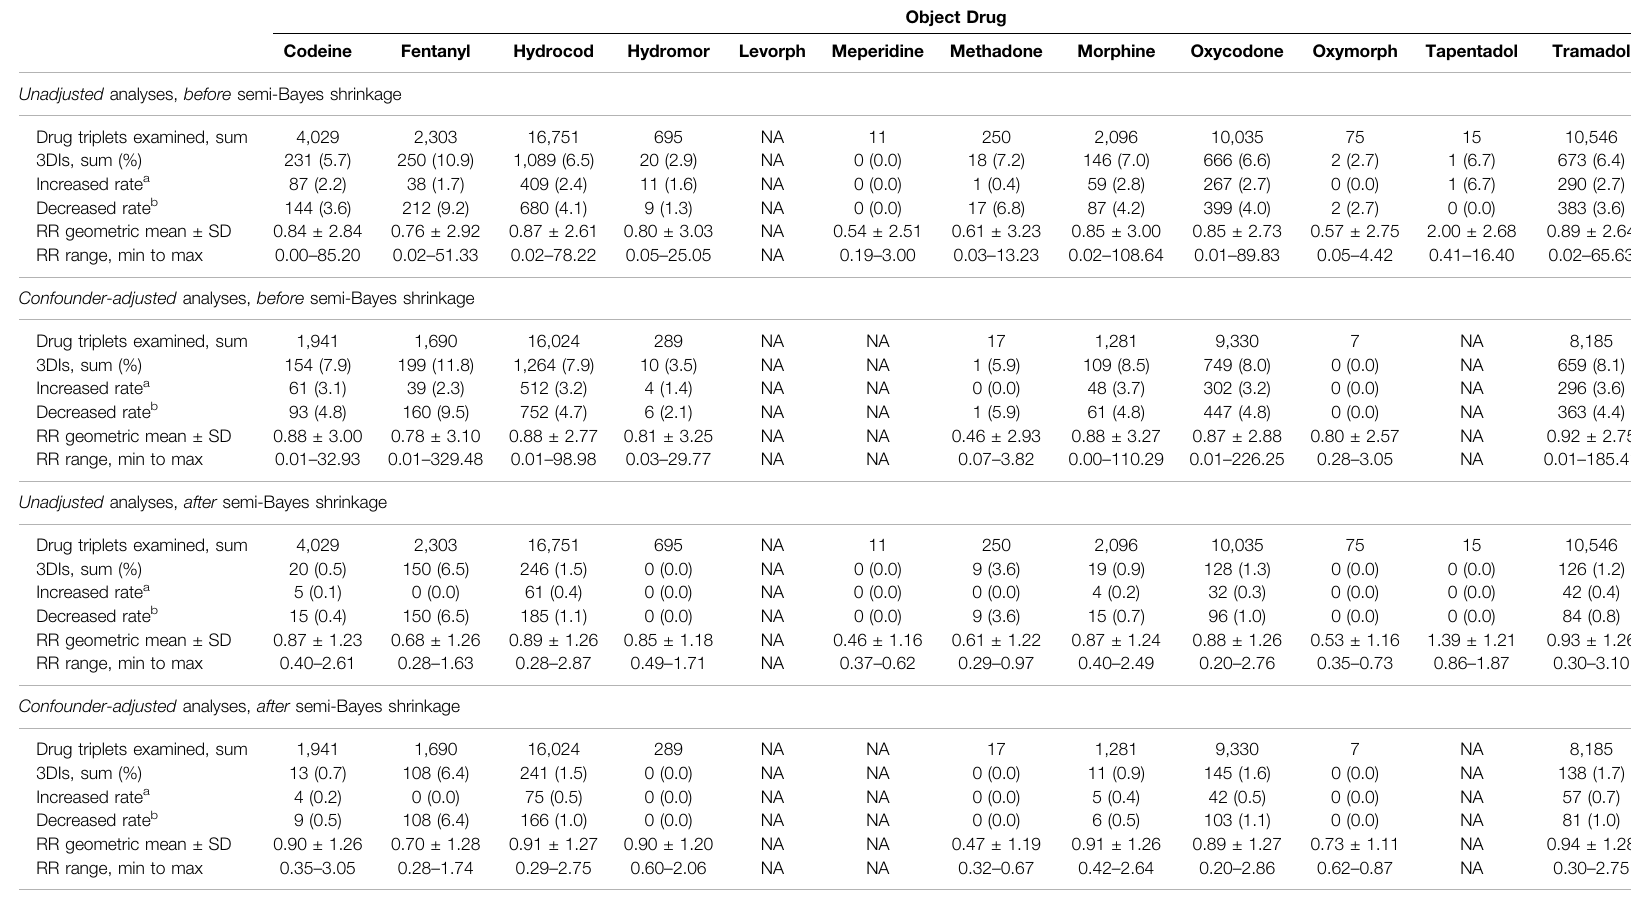
TABLE 2 | Summary data on rate ratios for unintentional traumatic injury, by object